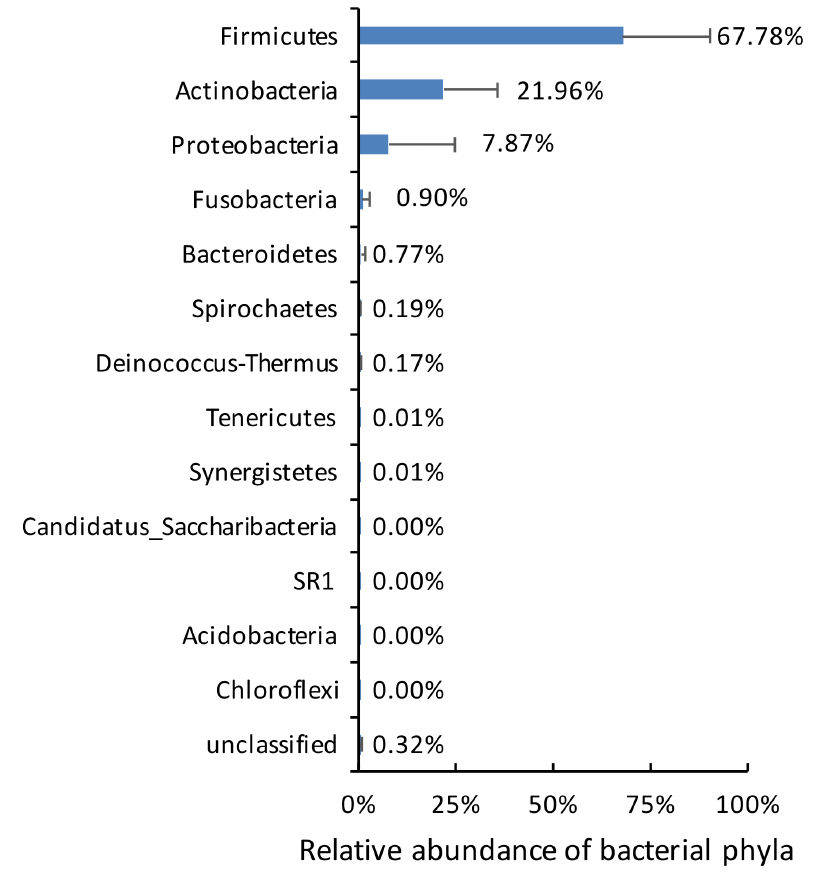
Fig 1. Average relative abundance of bacterial phyla composition in deep caries